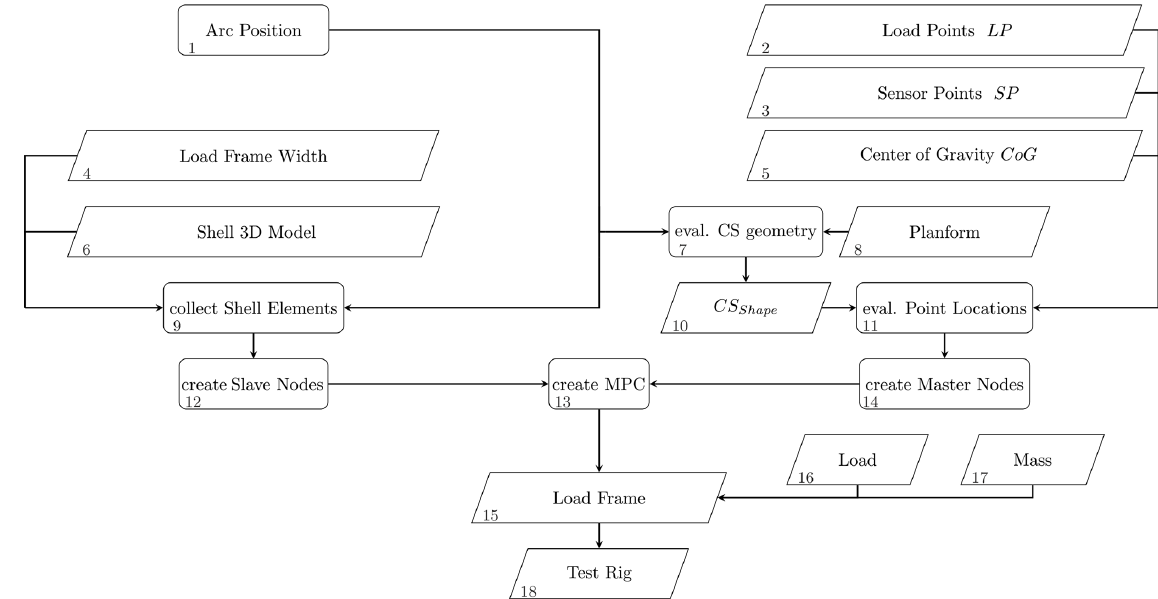
Figure 4. Flowchart of the procedure to model the boundary conditions in the TestRig